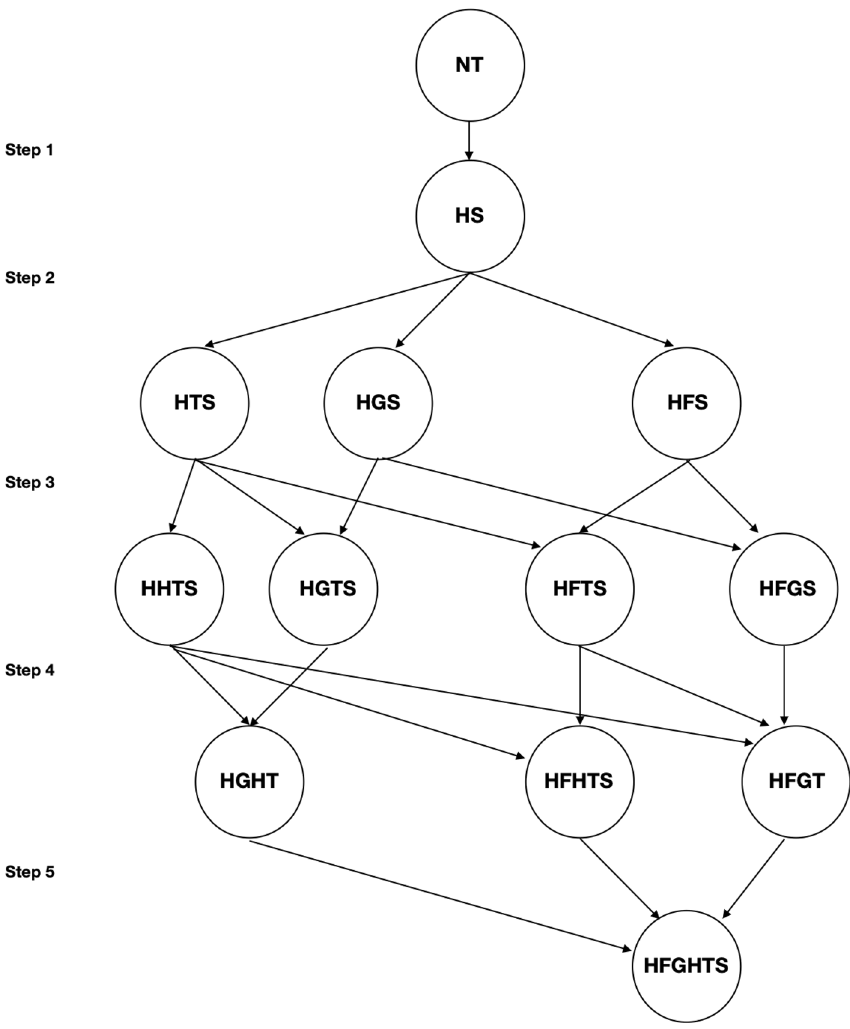
Figure 1. The hierarchy analysis process used to analyse the effect of the treatments on N. trichotoma and the establishment of the broadcast seeds. The treatment codes shown in the flowchart are defined in Table